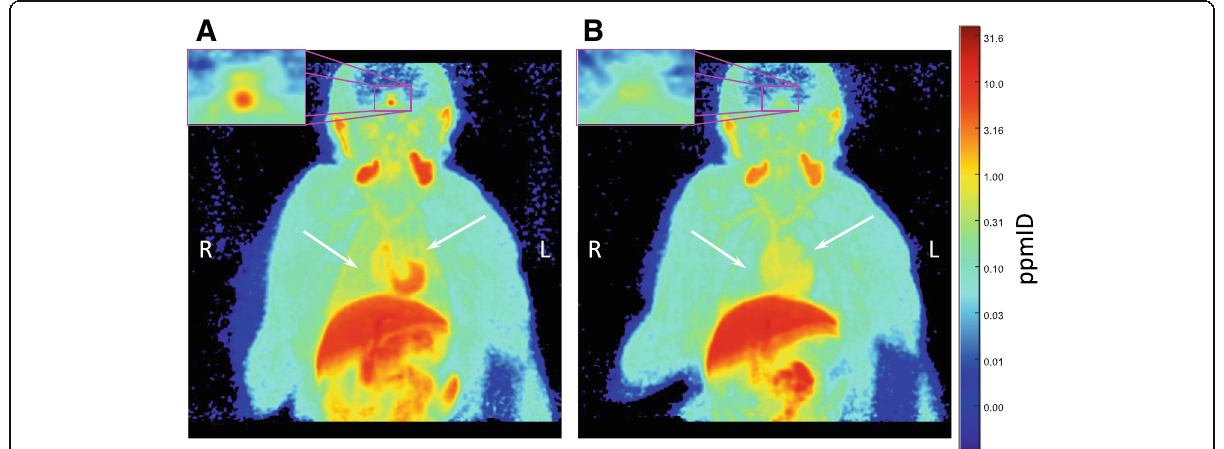
Fig. 2 Coronal slices of summation PET images (3 – 60 min) showing the distribution of radioactivity after intravenous injection of 11 C-VC-002 (in units of parts-per-million of the injected radioactivity dose, i.e., ppmID) in a non-human primate (NHP#3) at a baseline and b after inhalation of ipratropium (150 μ g/kg). The highest inhaled dose was represented to provide a visual impression of the dosing effect. Arrows denote the lungs, and the insert shows the pituitary gland. The color scale is